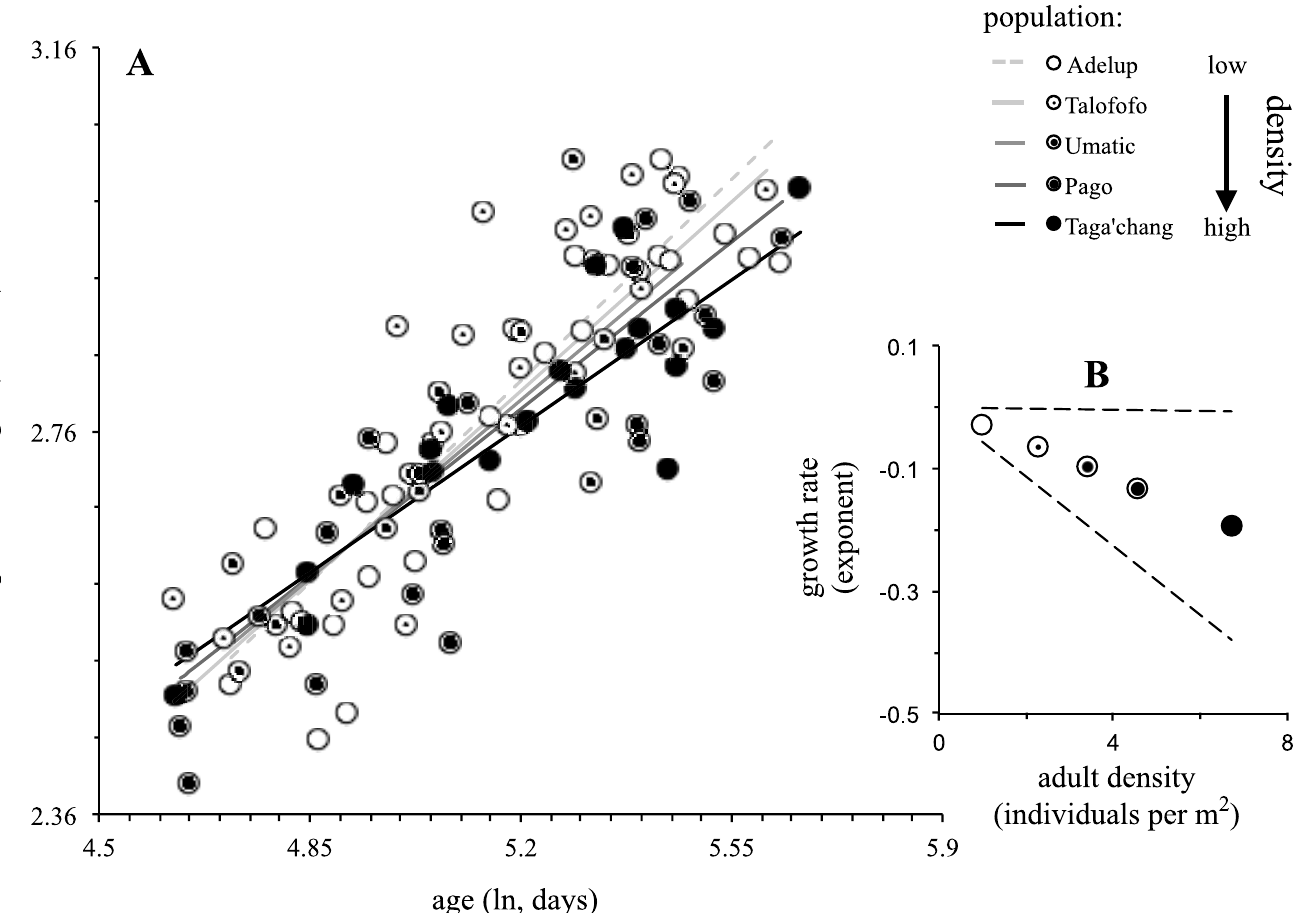
Fig 4. Variation among populations in growth rate as a function of adult density ( A ). Also shown ( B ) are population coefficients computed using the best- supported model for adult density reported in Table 2. Symbols are proportionally filled according to adult density, from white (low adult density) to black (high adult density). See Fig 3 legend for other